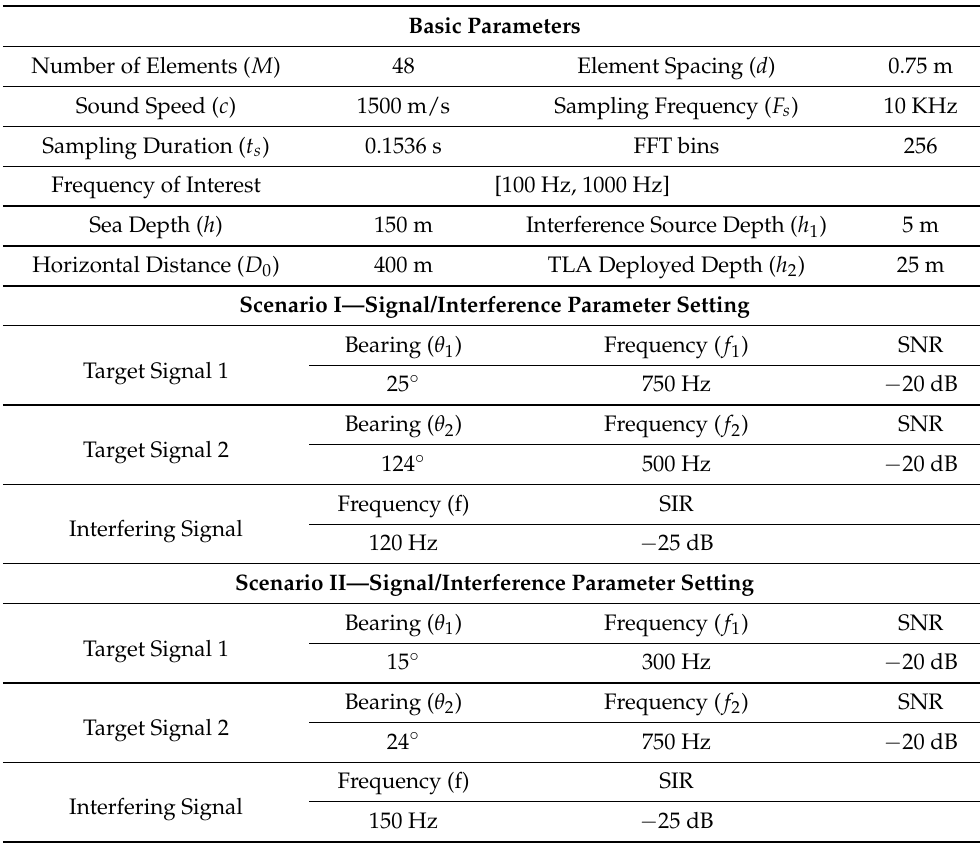
Table 1. Parameter setting